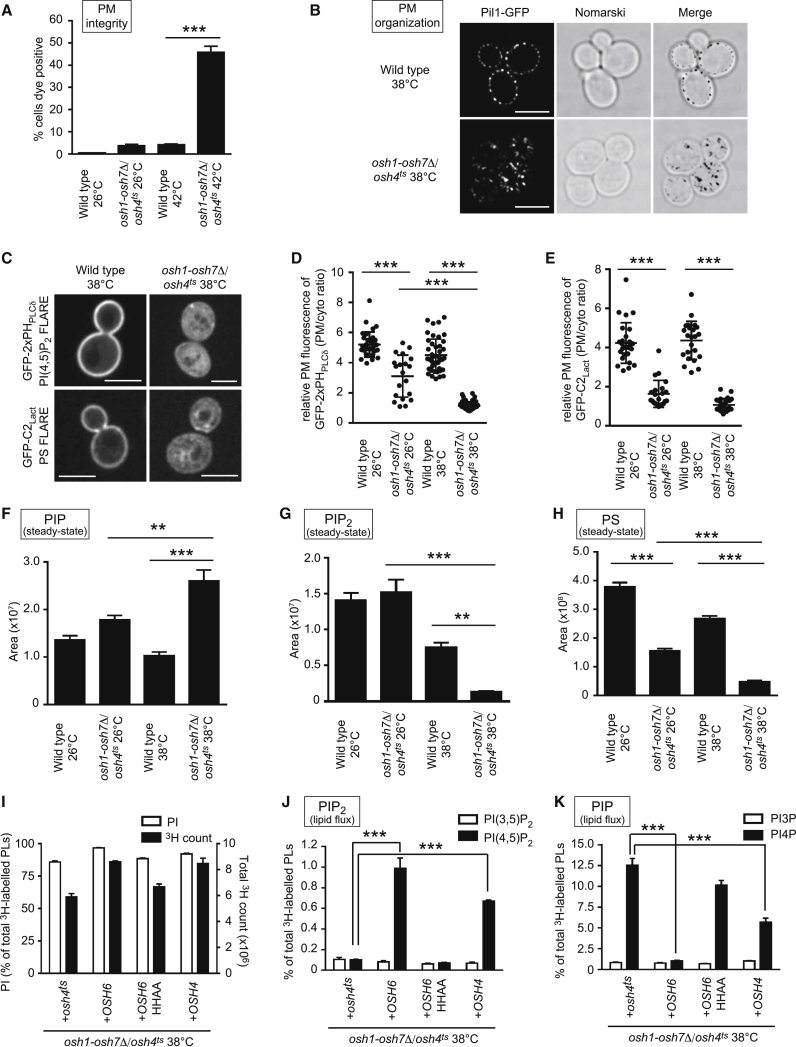
Osh Proteins Maintain PI(4,5)P2 and PS Levels at the PM(A) PM integrity of wild-type and osh1-7Δ/osh4ts cells. Cells incubated at 26°C or 42°C for 15 min were stained with propidium iodide and analyzed by flow cytometry. Data represent the mean ± SEM (n = 3).(B) Pil1-GFP localization in wild-type and osh1-7Δ/osh4ts cells.(C) PI(4,5)P2 (GFP-2xPHPLCδ) and PS (GFP-C2Lact) FLARE localization in wild-type and osh1-7Δ/osh4ts cells.(B and C) Cells were shifted to 38°C for 2 h. Scale bars, 4 μm.(D and E) Quantitation of GFP-2xPHPLCδ (D) and GFP-C2Lact (E) signals in the PM. Relative PM and cytosolic signals were measured as described in STAR Methods. Data represent mean ± SD (n ≥ 20 cells).(F–H) Lipidomic analysis of PIP (F), PIP2 (G), and PS (H) in cells cultured at 26°C or 38°C for 2 h. Data represent mean ± SEM (n = 5).(I–K) Measurements of inositol incorporation and PI synthesis (I), synthesis of the PIP2 variants PI(3,5)P2 and PI(4,5)P2 (J), and synthesis of the PIP variants PI3P and PI4P (K) as monitored by 3H-inositol labeling and HPLC analysis of cells cultured at 38°C for 1 h. Data represent the mean ± SEM (n = 3).∗∗p < 0.01, ∗∗∗p < 0.001. See also Figure S1.